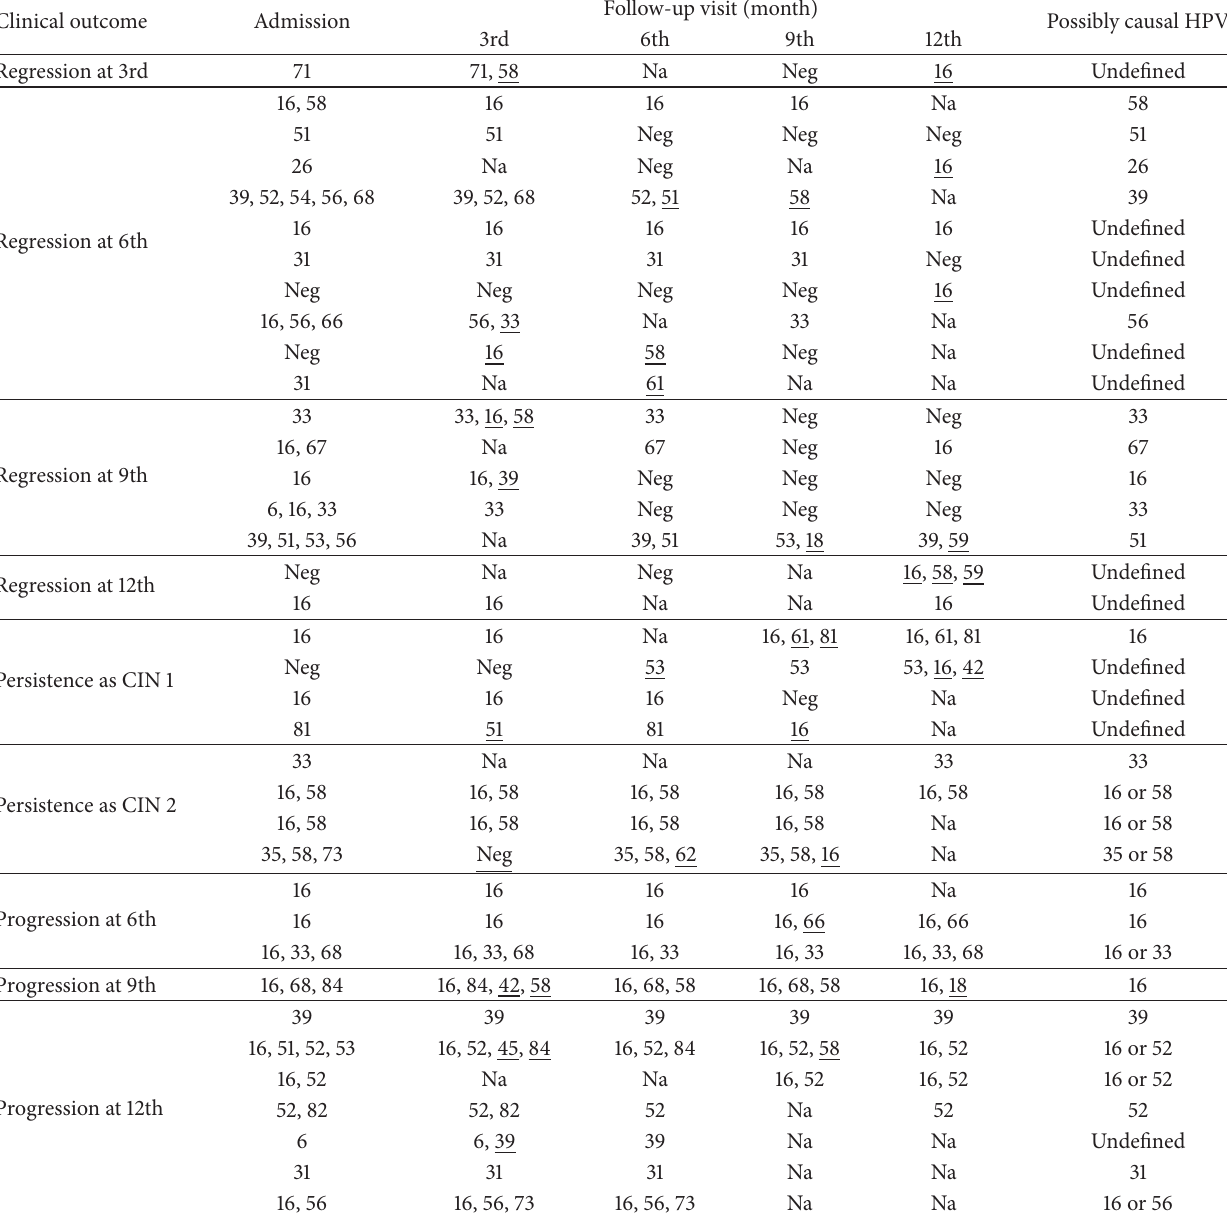
Table 1: Distribution of HPV types at admission and every three months of followup according to clinical outcome of women with CIN 2. Clinical